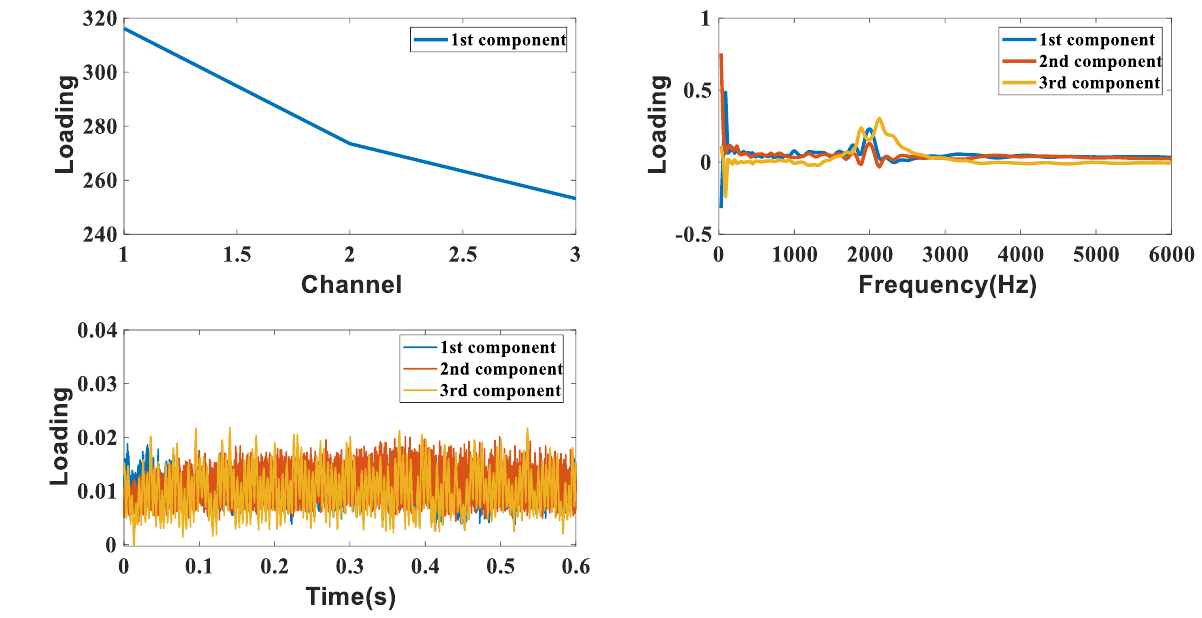
Figure 9. Parallel factor decomposition of simulated signal.